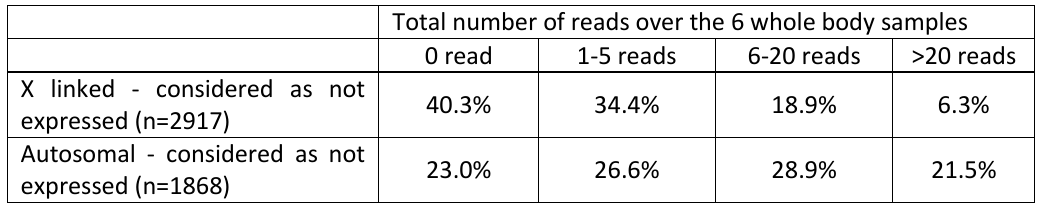
Table A : Expression in whole-body samples of males, sexual females and parthenogenetic females for X- linked and autosomal genes that were considered as not expressed in the 3-morph x 3-tissue RNAseq experiment.